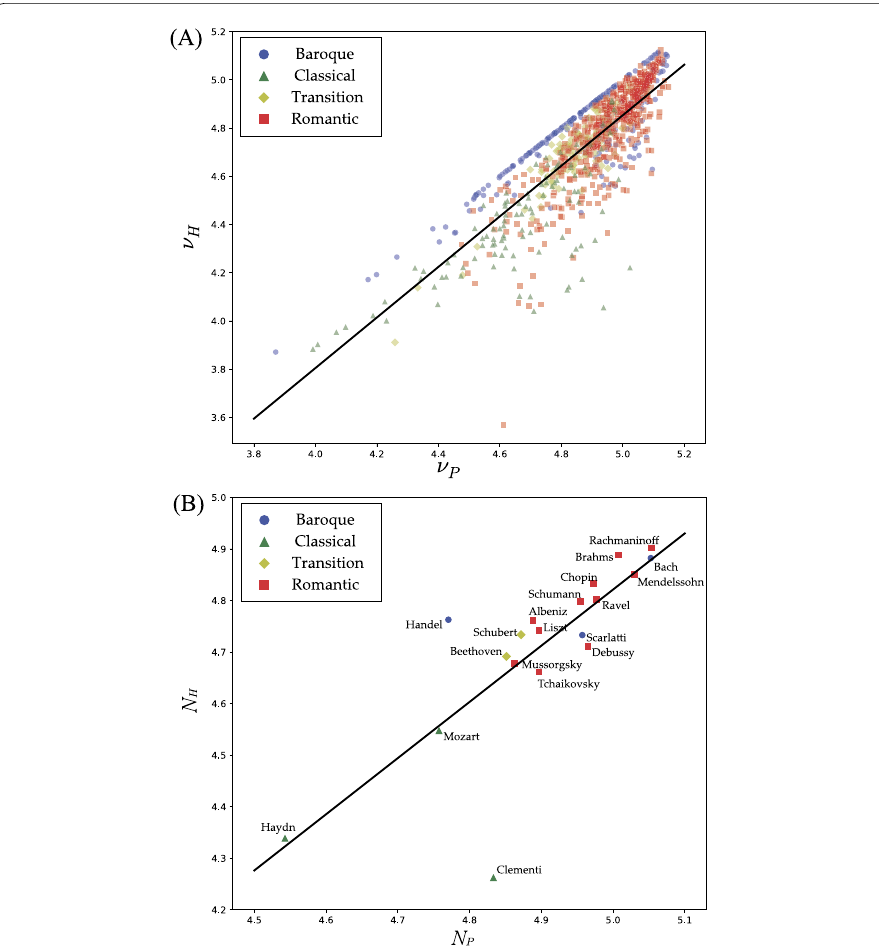
Figure 4 ( A ) Scatter plot of the H- and P-novelty scores of the piano works, with a high level of correlation (Spearman correlation 0.82 ± 0.01). ( B ) The H- and P-novelty scores of composers (Spearman correlation 0.83 ± 0.11). A notable outlier is Muzio Clementi who shows a significantly small H-novelty given